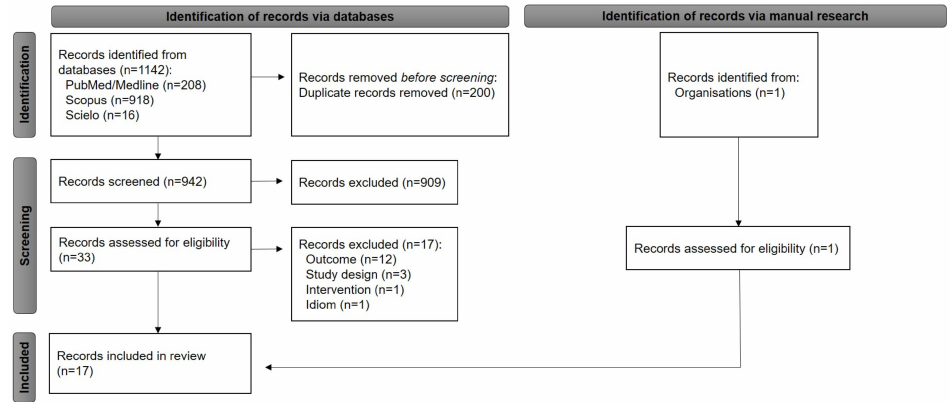
Figure 1. Flow diagram of the systematic review. Fonte: Adapted from Page et al.